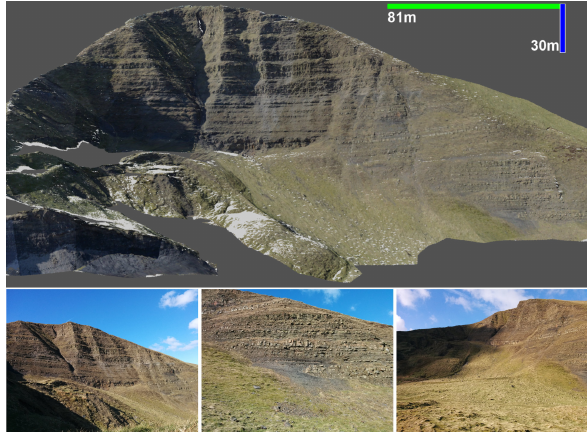
Figure 6: Overview rendering of the Mam Tor dataset as textured surface model (top, scale included) and a selection of supplementary photos to be incorporated